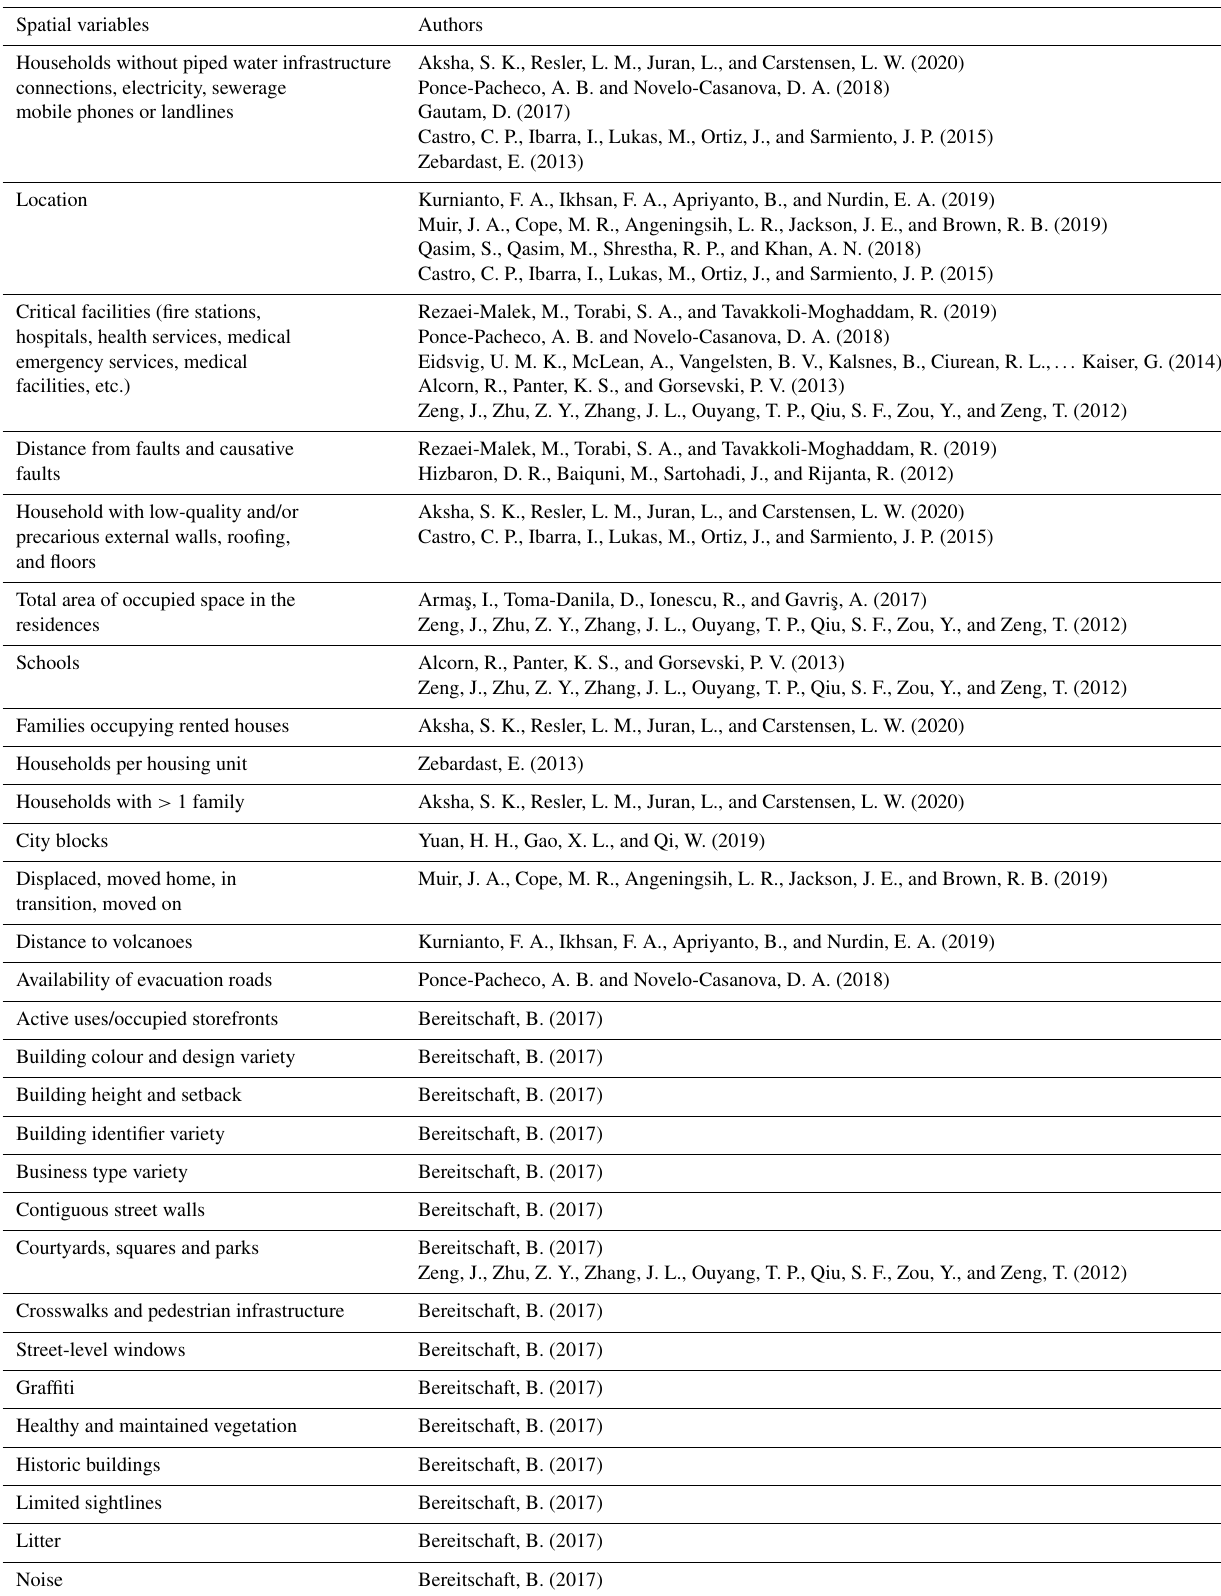
Table 4. Spatial variables for socio-economic vulnerability